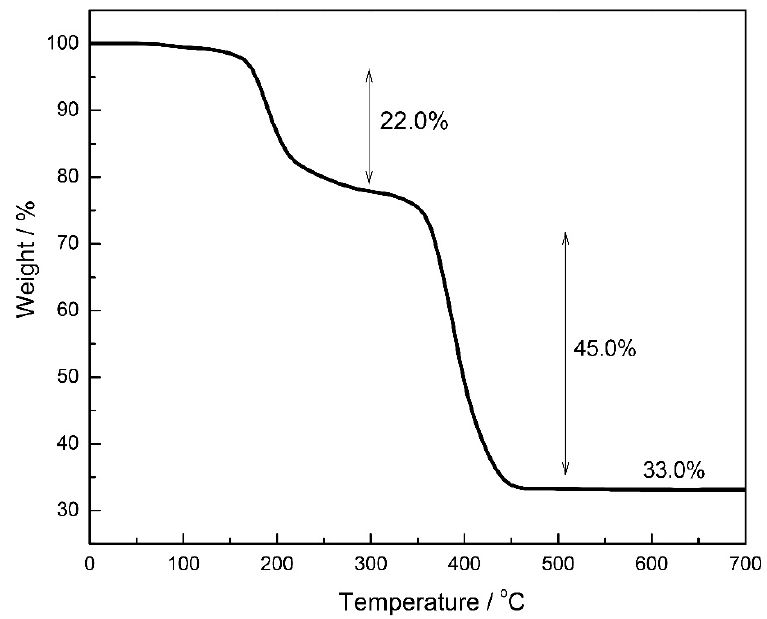
Figure 2. Thermogravimetric analysis of FH@Ni(MOF).